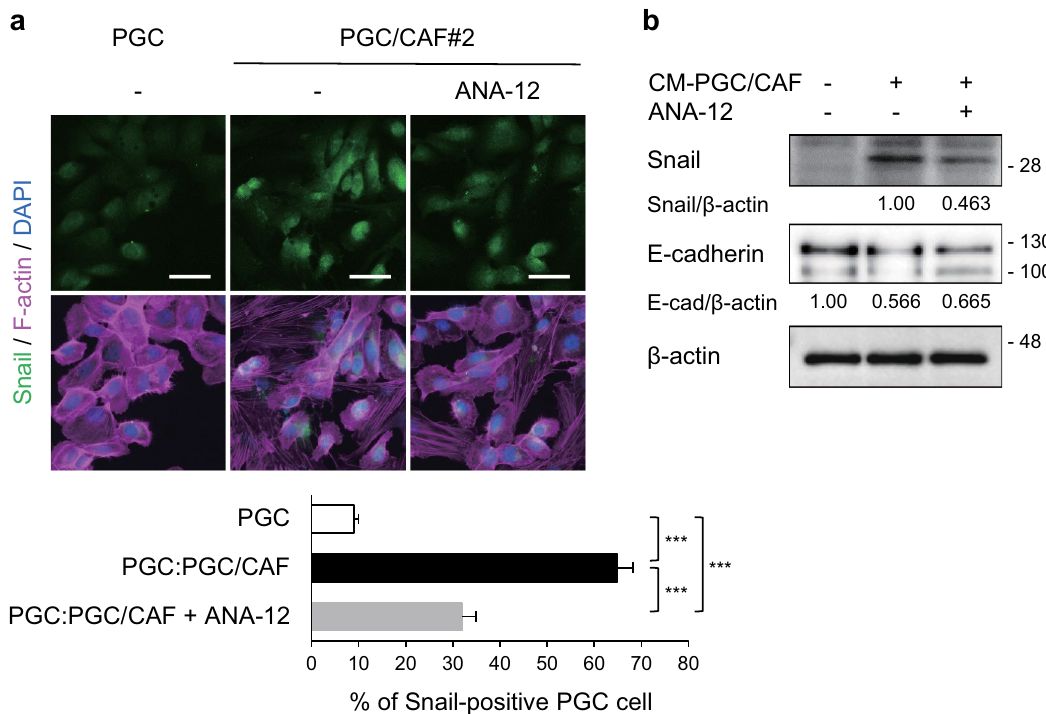
Figure 3. Inhibition of CAF-mediated upregulation of Snail in PGC cells by a TRKB inhibitor. PGC cells were co-cultured with CAFs ( a ) or CM from PGC/CAF co-cultures ( b ) for 4 days in the presence or absence of a TRKB inhibitor, ANA-12 (10 μM). ( a) Snail expression levels were examined using immunofluorescence analysis. Histogram shows the percentage of Snail-positive cells per field as the mean ± SEM. The percentage were calculated from more than 11 fields (at least 100 cells per field) of each group. PGC:PGC/CAF, direct- co-cultured PGC cells with CAFs. *** P < 0.001 (Tukey’s test). ( b) Snail and E-cadherin expression levels were examined using WB analysis. The relative amounts of Snail are indicated as the ratio of each protein band relative to the loading control, β-actin. Scale bars, 50